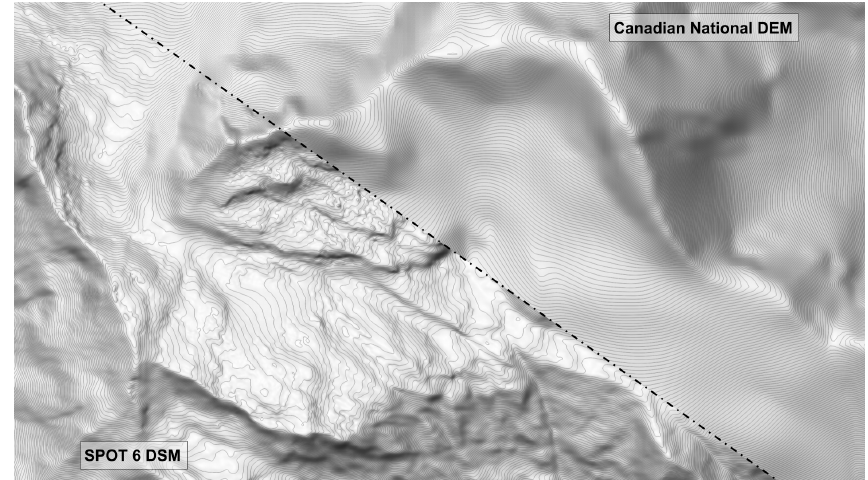
Figure 8. Comparison of existing 18m resolution CDEM to 5m resolution SPOT 6 satellite stereo DSM, derived from our data preparation pipeline. Canadian DEM data from Natural Resources Canada.